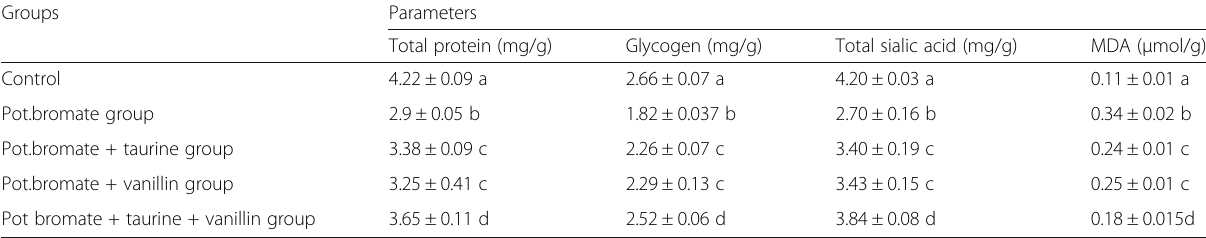
Table 1 Effect of taurine and/or vanillin on total protein, glycogen, total sialic acid content, and malondialdheyde (MDA) activity in testes of the potassium bromate-treated rats